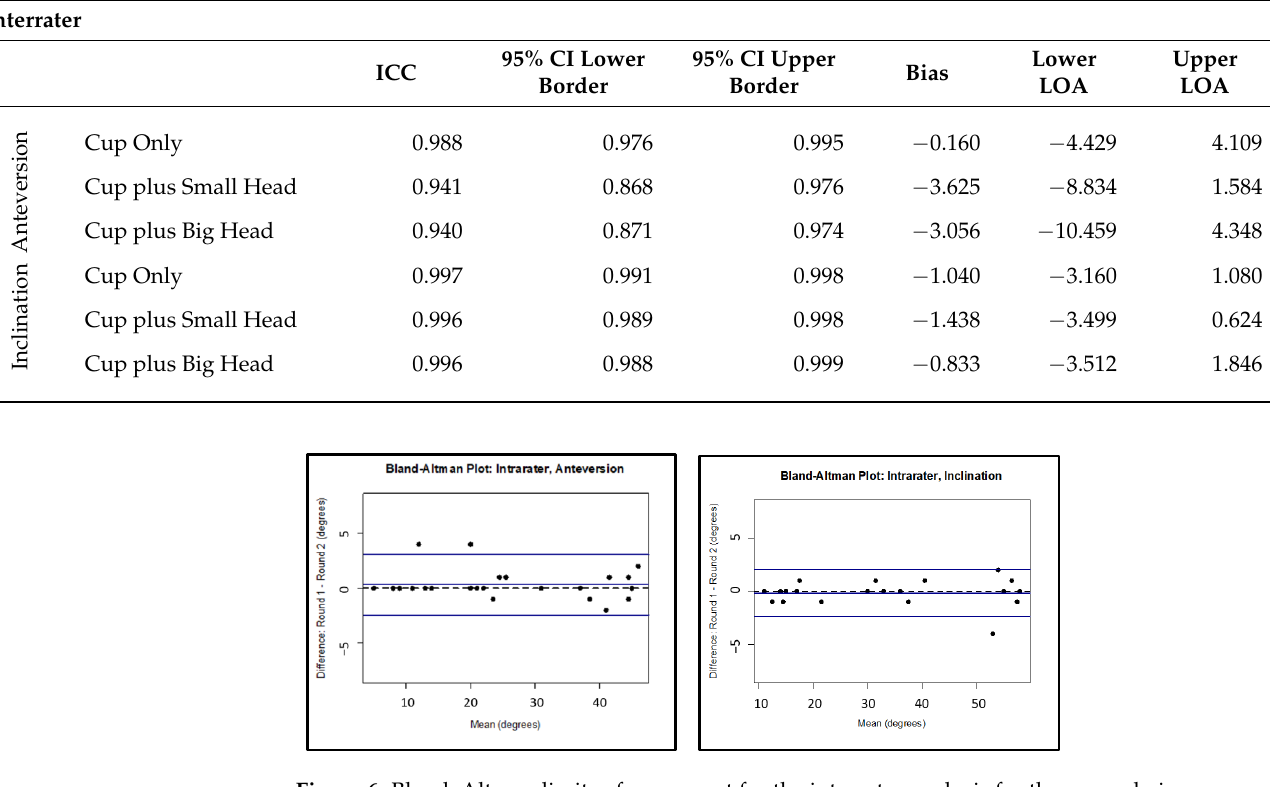
Figure 6. Bland – Altman limits of agreement for the intrarater analysis for the cup only images. Figure 6. Bland–Altman limits of agreement for the intrarater analysis for the cup only Intermethod reliability, defined as an agreement between the measurements of one investigator using the JointPoint compared to the true measurement acquired using the robotic coordinate measuring system, demonstrated strong agreement for both antever- sion and inclination, with an interclass coefficient of 0.986 (95% CI: 0.972 – 0.993) calculated for anteversion and 0.993 (95% CI: 0.989 – 0.995) for inclination. Bland – Altman analysis for the intermethod agreement demonstrated limits of agreement for anteversion of −5 to 4 degrees centered about −1 degree. Limits of agreement for inclination were found to be 0 to 4 degrees, centered at about 2 degrees. Intermethod agreement remained strong for the measurements also taken with small and large femoral heads in place. Interestingly, bias was also centered around approximately two degrees for the Bland – Altman inclination measurements for images with small and large heads in place, similar to what was ob- served for the images only containing the acetabular cup. Full detail of the intermethod agreement measurements is contained in Table 3. Bland – Altman plots demonstrating lim- its of agreement for the images with the acetabular component only are presented in Fig- ure 7. Table 3. Complete intermethod analysis comparing the software analysis to the CMM analysis in- cluding interclass correlation coefficient (ICC) and Bland – Altman bias and limits of agreement (LOA). Intermethod